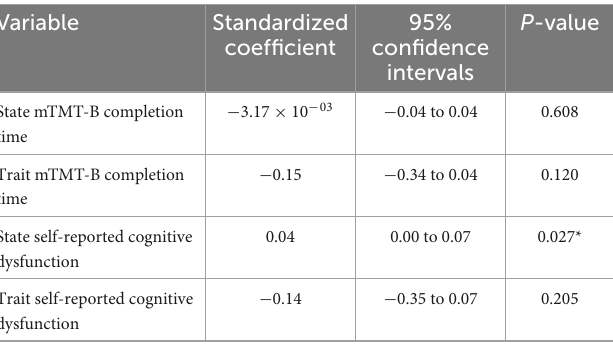
TABLE 7 Model estimates for real-time associations between cognitive functioning and self-reported sense of